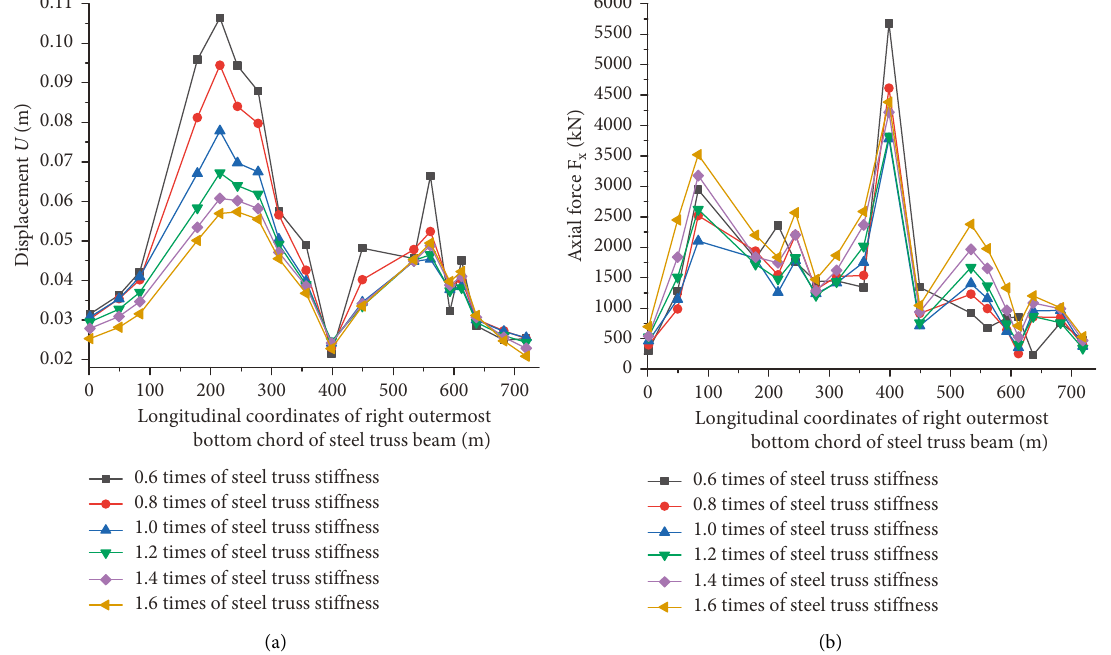
Figure 8: Longitudinal distribution of chord displacement U and axial force Fx along with the bridge deck for bridges with different multiples of steel joist stiffness under earthquake action. (a) Longitudinal distribution of the maximum value of the displacement and (b) longitudinal distribution of the maximum value of the axial